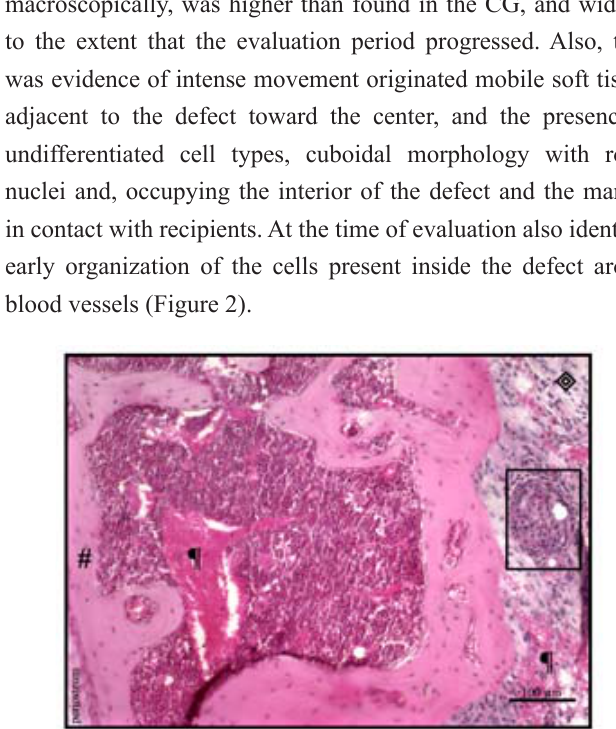
TABLE 1 - Mean percentage of bone repair displayed by period of observation, for animals of groups control (CG) and MSC/PRP-treated (MPG) and estimated p values comparing data of % of bone filling, per period, of treatment MPG versus treatment CG.